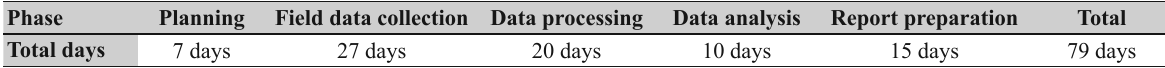
Number of days spent for development of the inventory.